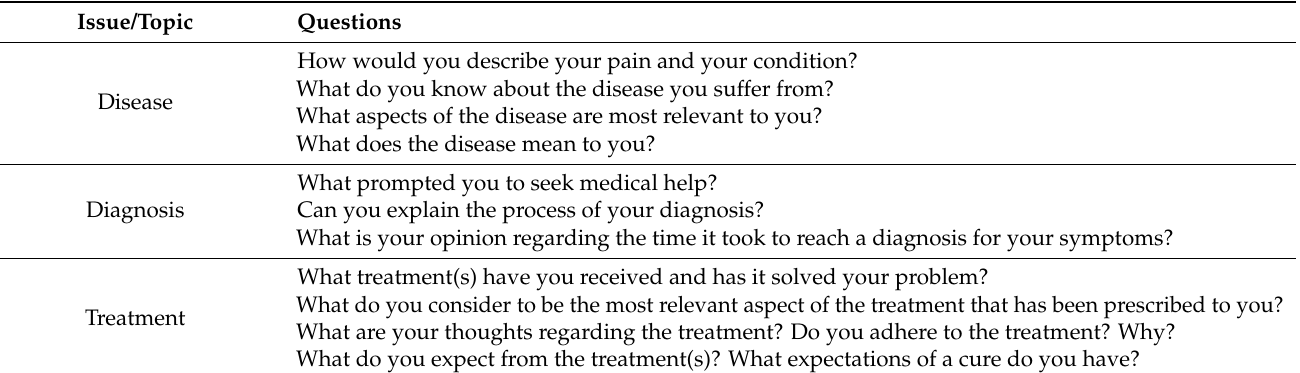
Table 1. Semi-structured interview